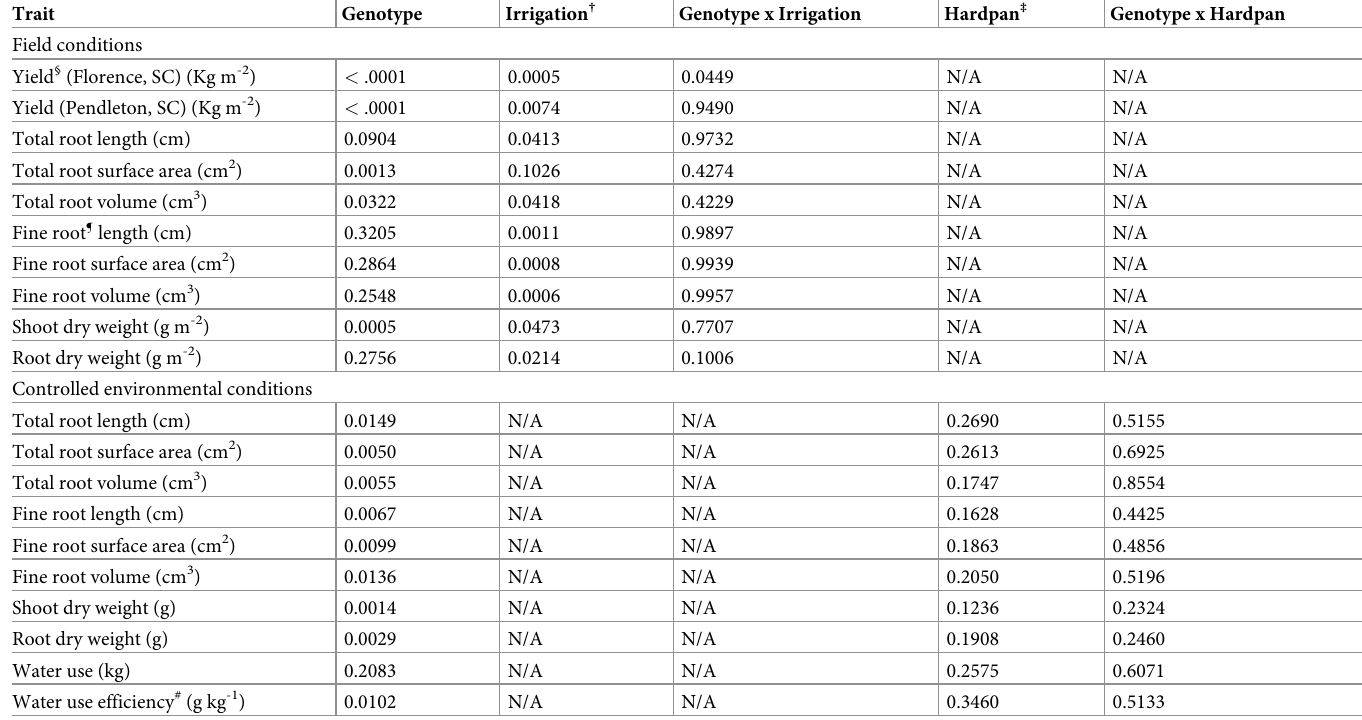
Table 3. Analysis of variance results on effects of genotype, irrigation, their interaction (for the field experiments), presence of hardpan, and it’s interaction with genotype (for the controlled environmental experiments) for various traits measured in the study. The field level measurements of root and shoot traits (total and fine root length, surface area, and volume, and shoot and root dry weights) were made only at one location (Florence, SC,